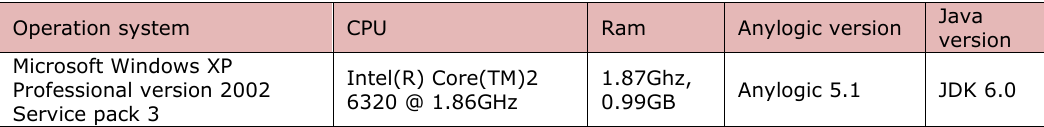
Table 3. “Environment specification”.